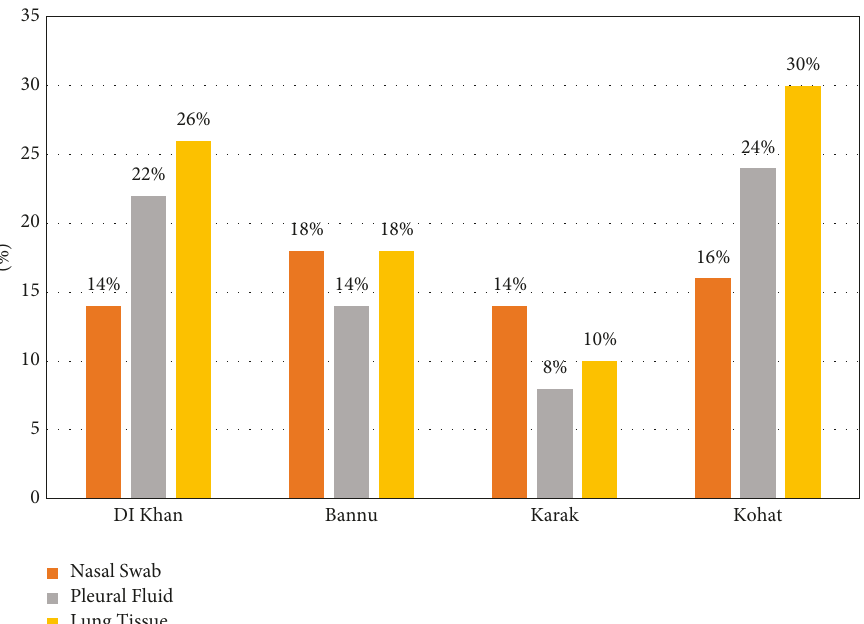
Figure 3: Graphical representation of sample-wise prevalence Mycoplasma capricolum subsp. capripneumoniae by PCR in southern areas of